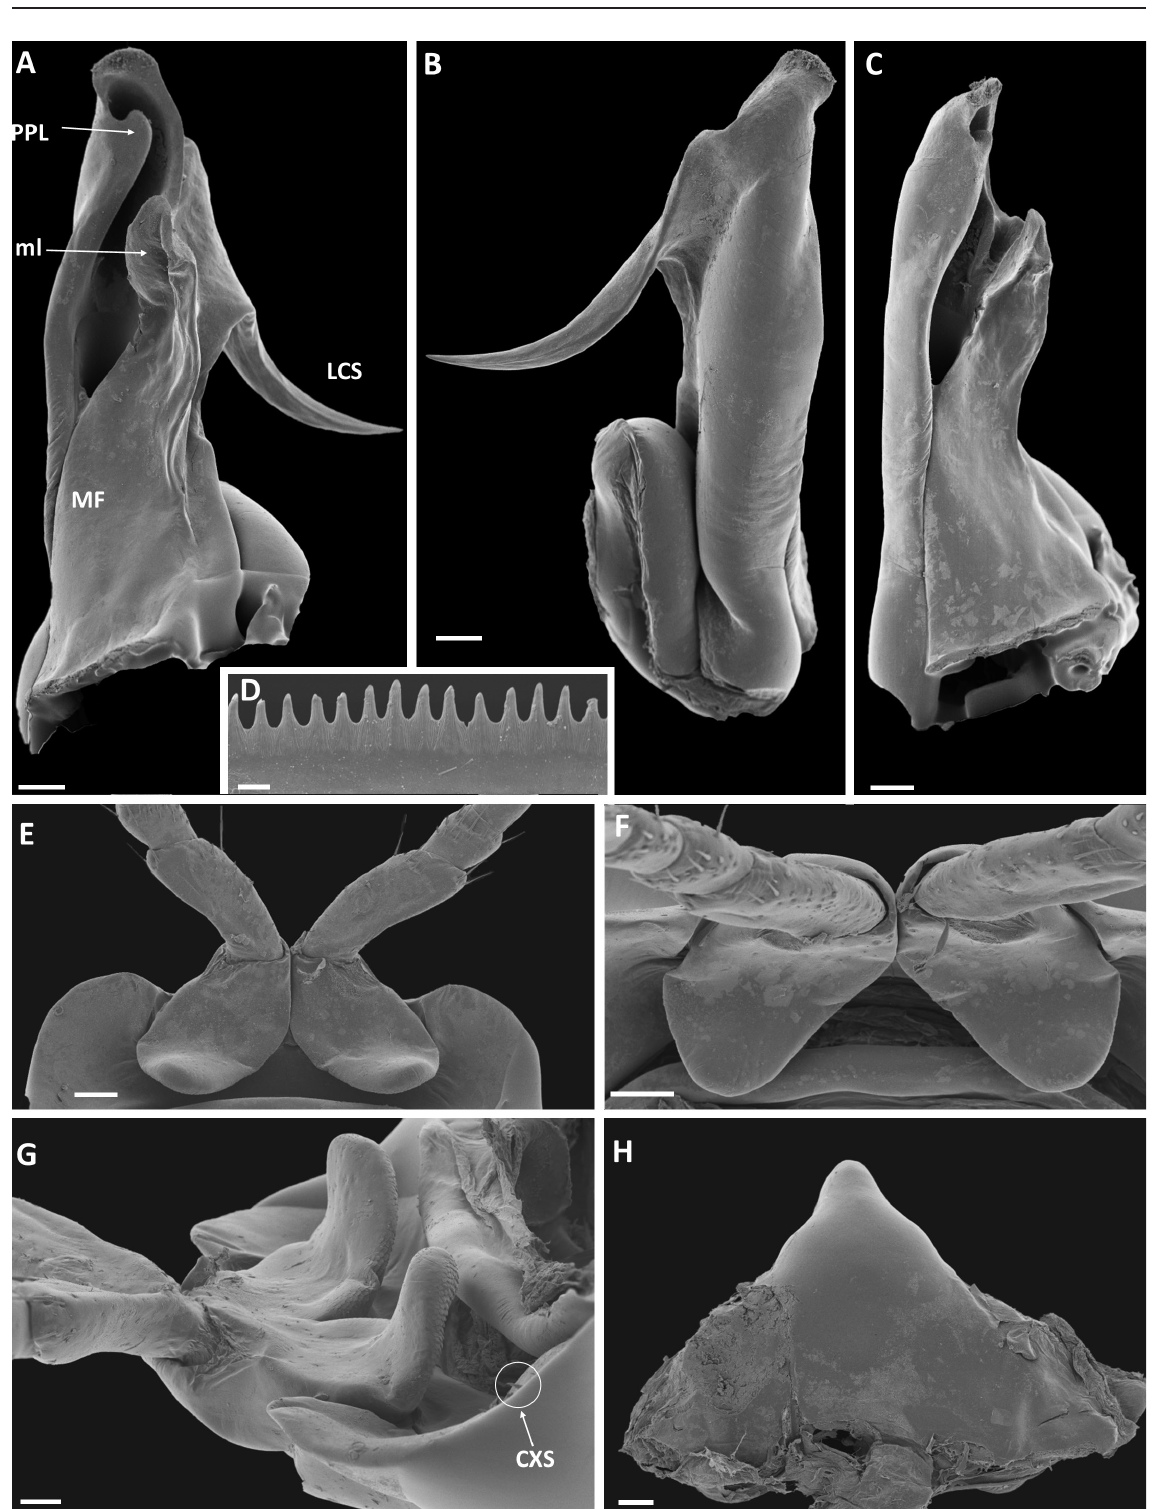
Fig. 54. Spinotarsus axeli sp. nov., holotype, ♂ (NHMD 621761). A–C . Left gonopod coxa. A. Anterior (-mesal) view. B. Posterior view. C. Mesal view. D . Midbody dorsal limbus. E–G . First pair of legs. E. Anterior view. F. Ventral view. G. Sublateral view. H . Sternum 9. Abbreviations: CXS = coxosternal seta; LCS = lateral coxal spine; MF = metaplical flange; ml = metaplical lobe; PPL = proplical lobe. Scale bars: A–C, E–F = 0.2 mm; G–H= 0.1 mm; D = 0.01